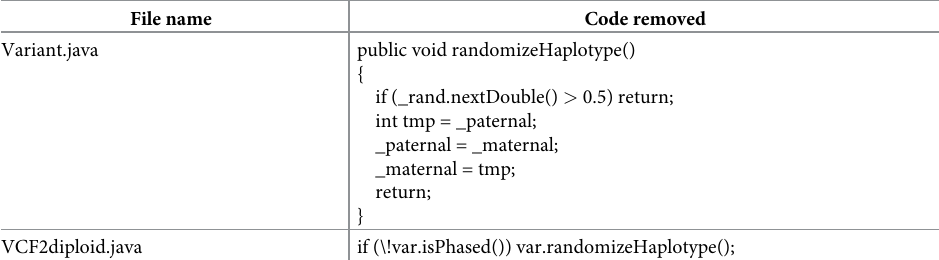
Table 1. Modifications to vcf2diploid